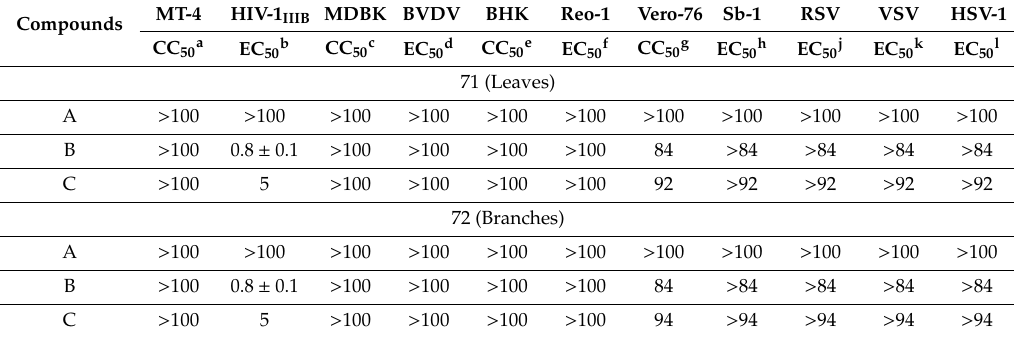
Table 1. Cytotoxicity and antiviral activity of Thymelaea hirsuta extracts against representatives